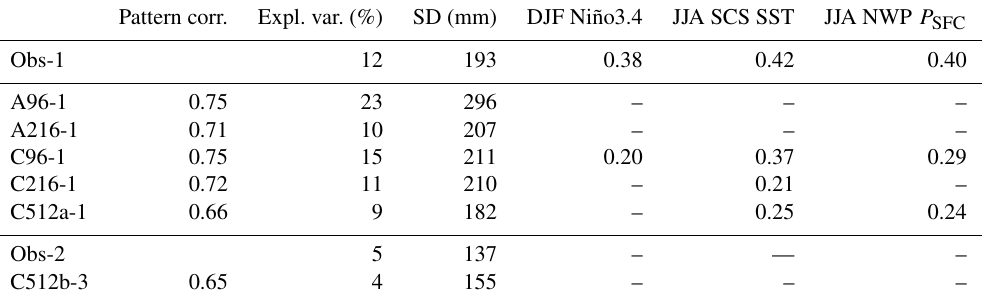
Table 3. Performance statistics of simulated EOTs compared to observations for JJA. Column (1) observed (Obs) and simulated (labelled by simulation name) EOT patterns; numbers indicate the order of the EOT pattern. (2) Linear pattern correlation coefficient of simulated and observed precipitation anomalies; (3) explained space–time variance of the EOT pattern; (4) standard deviation of the EOT time series; (5)–(7) Spearman’s rank correlation of the EOT time series with the (5) DJF Niño3.4 SST index; (6) JJA SCS SST index and (7) JJA NWP P SFC index (defined in Sect. 2.3). Correlation coefficients in (5)–(7) are shown only when they are significant at the 95% confidence level. Pattern